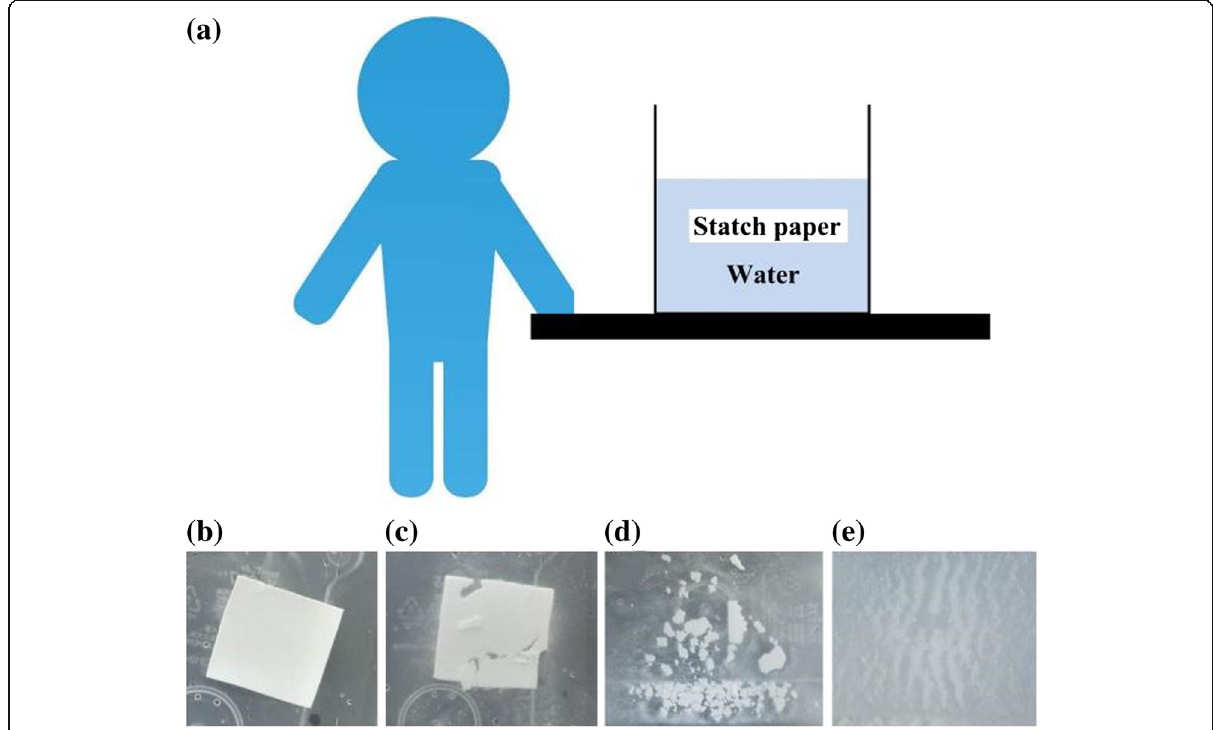
Fig. 7 a Degradability tests performed by dipping starch paper in water, b immediately, and after b 1, c 2, d 3, and e 4